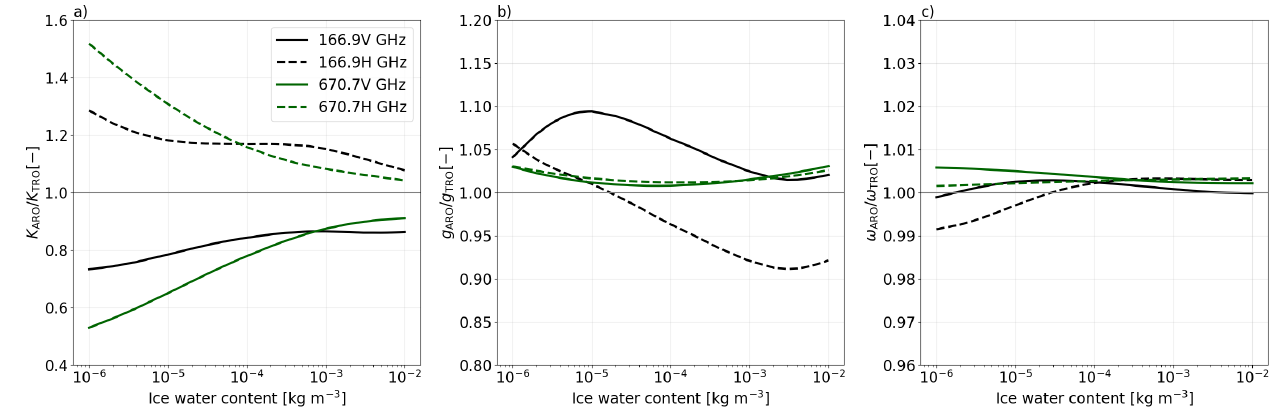
Figure 1. For the large plate aggregate and the particle size distribution of Field et al. [51] (tropical configuration), the bulk optical properties of azimuth random orientation (ARO) at both V and H polarisation were normalised by the corresponding properties in case of total random orientation (TRO) as a function of the ice water content. The results are presented at an Earth incident angle of 55 ◦ at 166.9 and 670.7GHz, based on ( a ) the extinction ( K ), ( b ) the asymmetry parameter ( g ) and ( c ) the single-scattering albedo ( ω ). For ARO, the single-scattering properties for a tilt angle of 0 ◦ were employed [13].